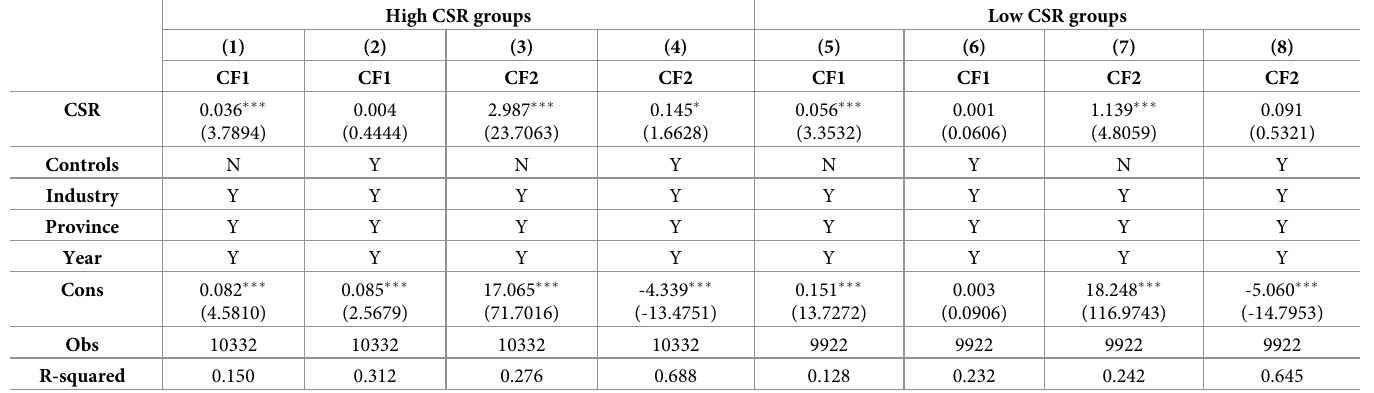
Table 6. Regression of high CSR and low CSR samples.